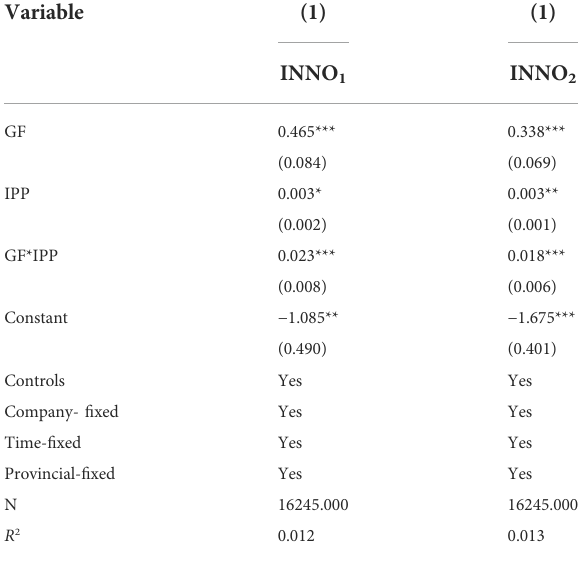
TABLE 9 Regression results of the green fi nance development, intellectual property protection, and enterprise green technology innovation